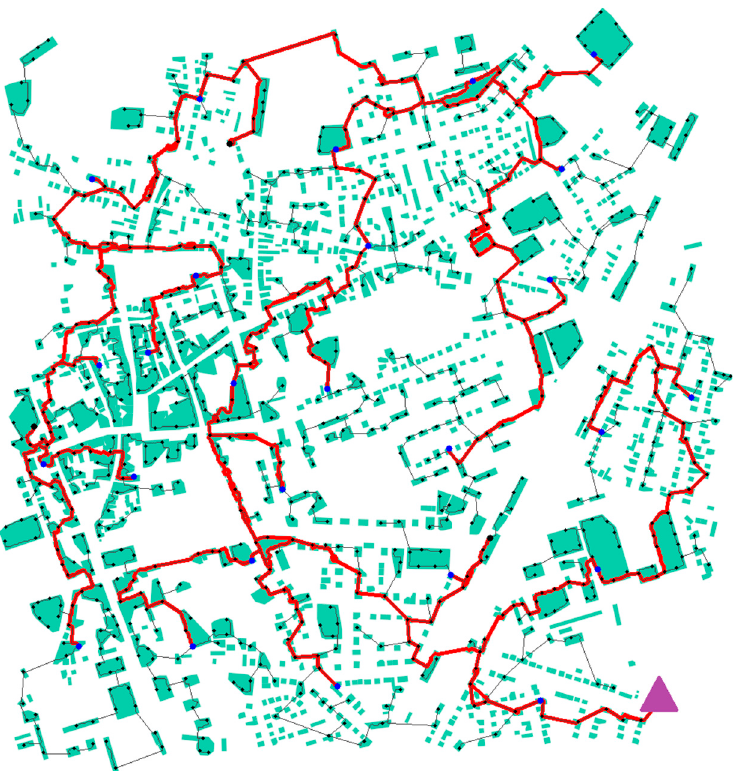
Figure 3 Network image of Varaždin city center in DiNeMo. Figure 3. Network image of Varaždin city center in